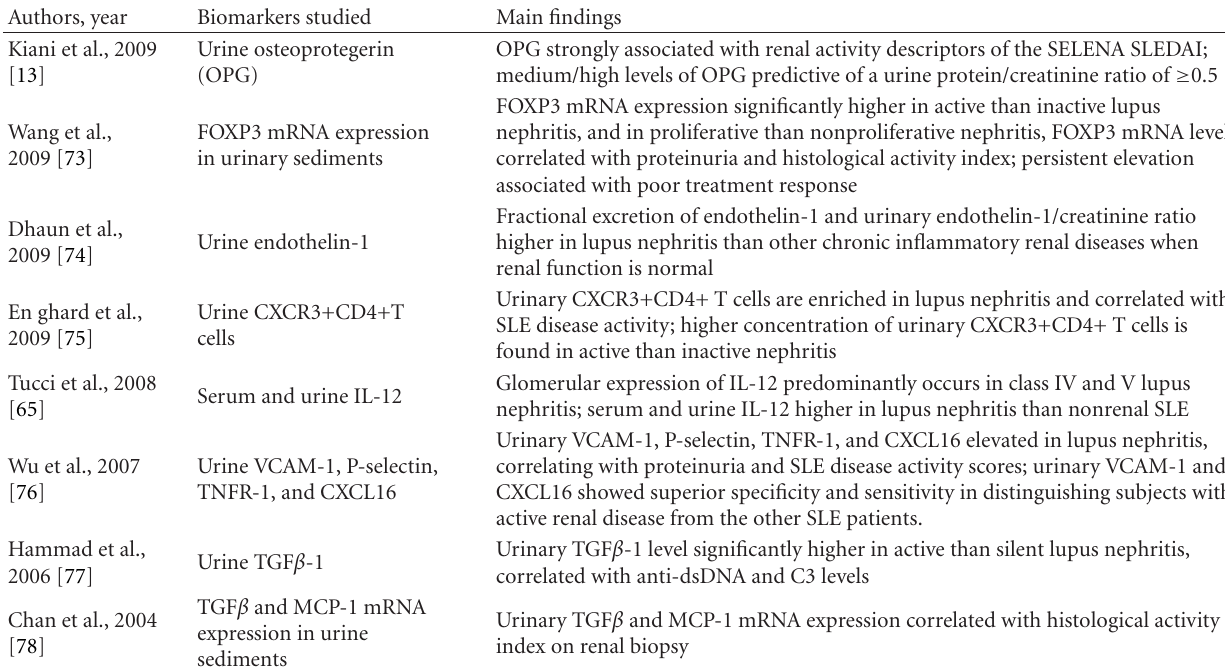
Table 2: Urine biomarkers that correlate with lupus nephritis activity in cross-sectional